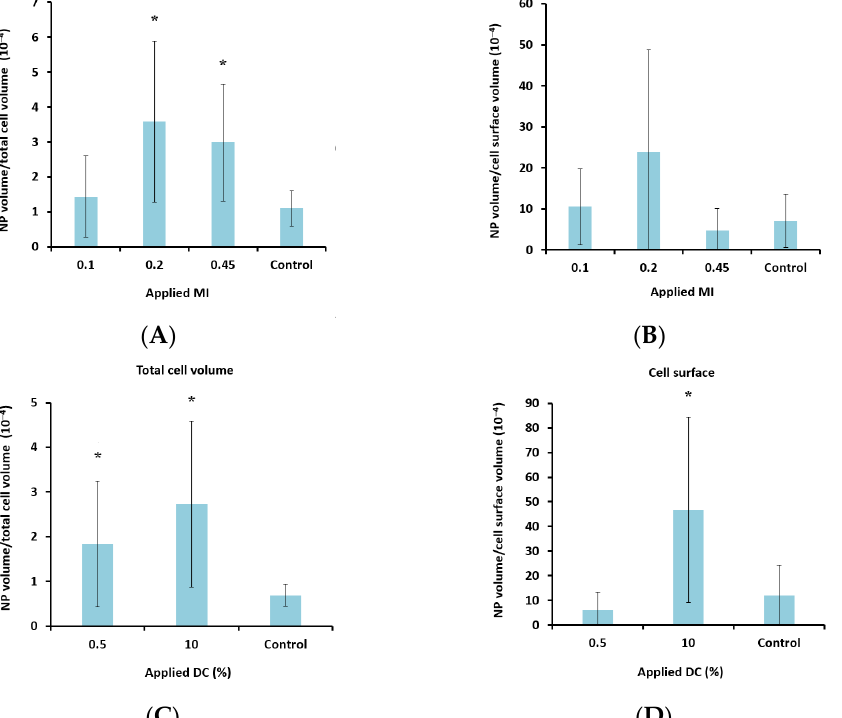
Figure 7. Effect of MI ( A + B ) and DC ( C + D ) on cellular uptake ( A + C ) and amount of nanoparticles (NP) colocalized with the cell membrane ( B + D ) after treatment with nanoparticle-loaded microbubbles and ultrasound. A + C : Data show the total number of nanoparticle voxels relative to the total number of cell voxels (nanoparticles both inside cells and colocalized with the cell membrane are included). B + D : Data show the total number of nanoparticle voxels relative to the cell surface voxels in the z-stack. Averages and the standard deviation are shown from n = 17–35 z-stacks for the treated cells and n = 11–13 for the untreated controls, and * indicates significant differences ( p < 0.05) compared to the untreated control cells.